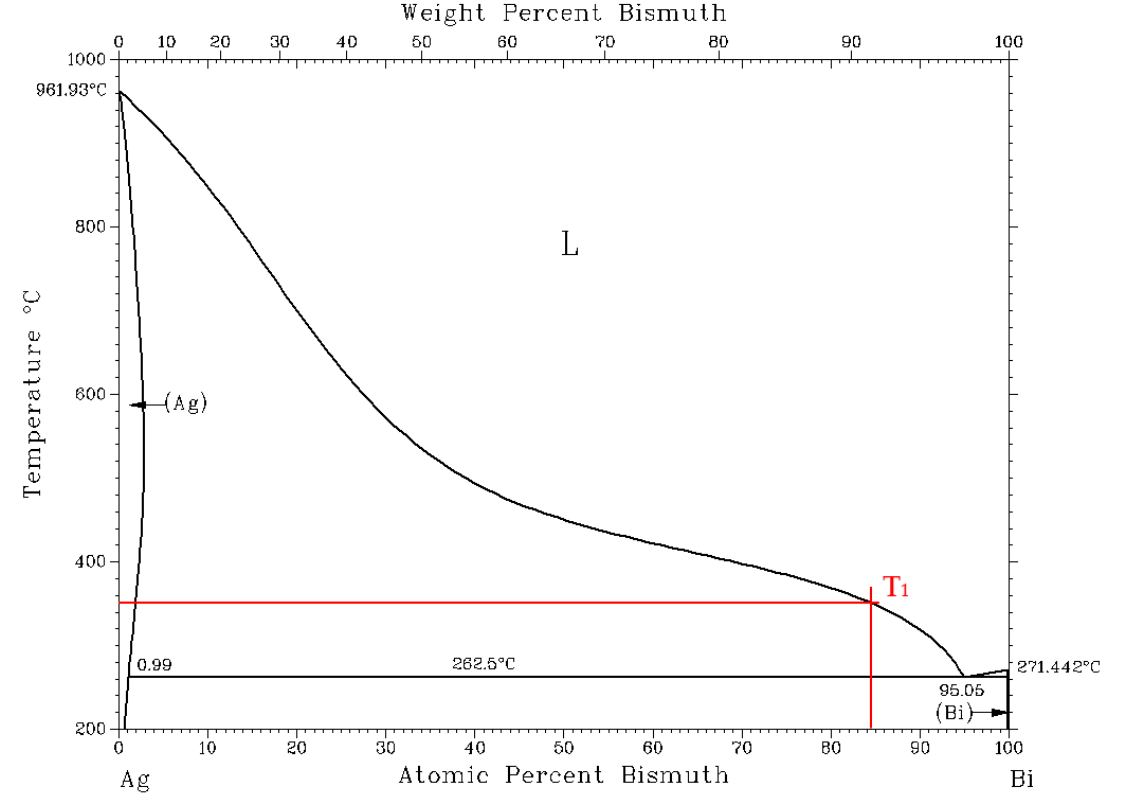
Figure 6. Equilibrium binary diagram of silver–bismuth system [30] with marked transformation of T 1.